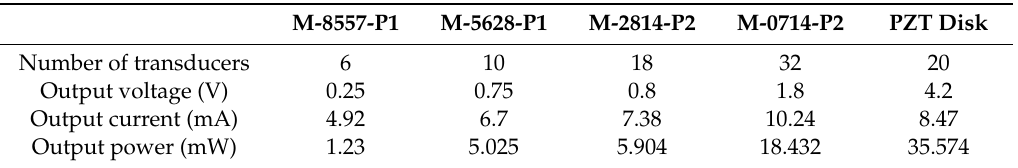
Table 3. Electric outputs of the platform for di ff erent piezoelectric transducers configurations for the footsteps of a 70 kg person.